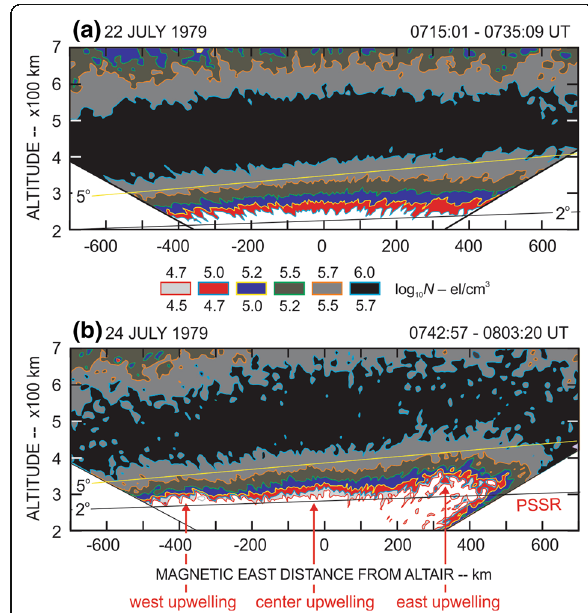
Fig. 1 ALTAIR isodensity contour maps of the equatorial F layer ( a ) starting at 0715 UT on 22 July 1979 and ( b ) starting at 0743 UT on 24 July 1979. Two lines, tilted 2 ° and 5 °, sloping upward to the east, are superimposed on both maps as estimates of the PSSR. Three upwellings appear in b as modulations in isodensity contours along bottomside F layer, but similar modulation is not seen in a . [The plot in b is a redrawing of the map in Tsunoda and White (1981), with added notation.] Mean SSN for 1979 was